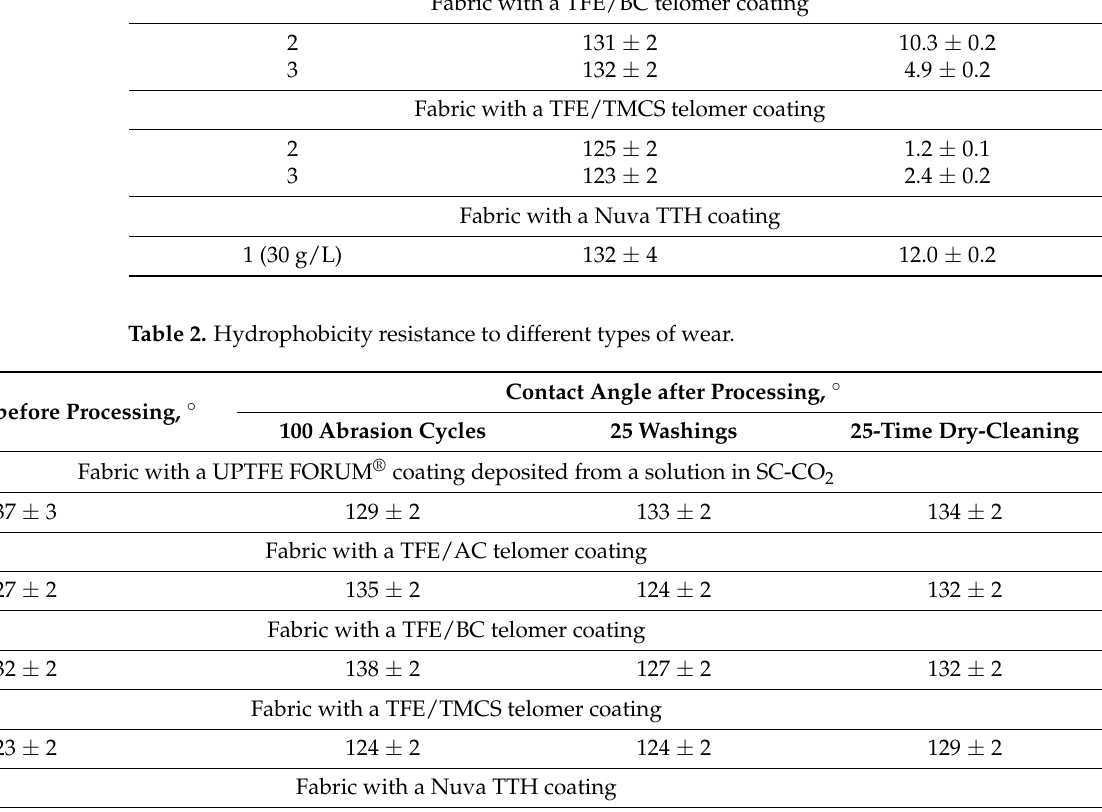
Table 1. Water-repellent properties of the polyester fabric with coatings containing UPTFE FORUM ® and a variety of TFE telomers.